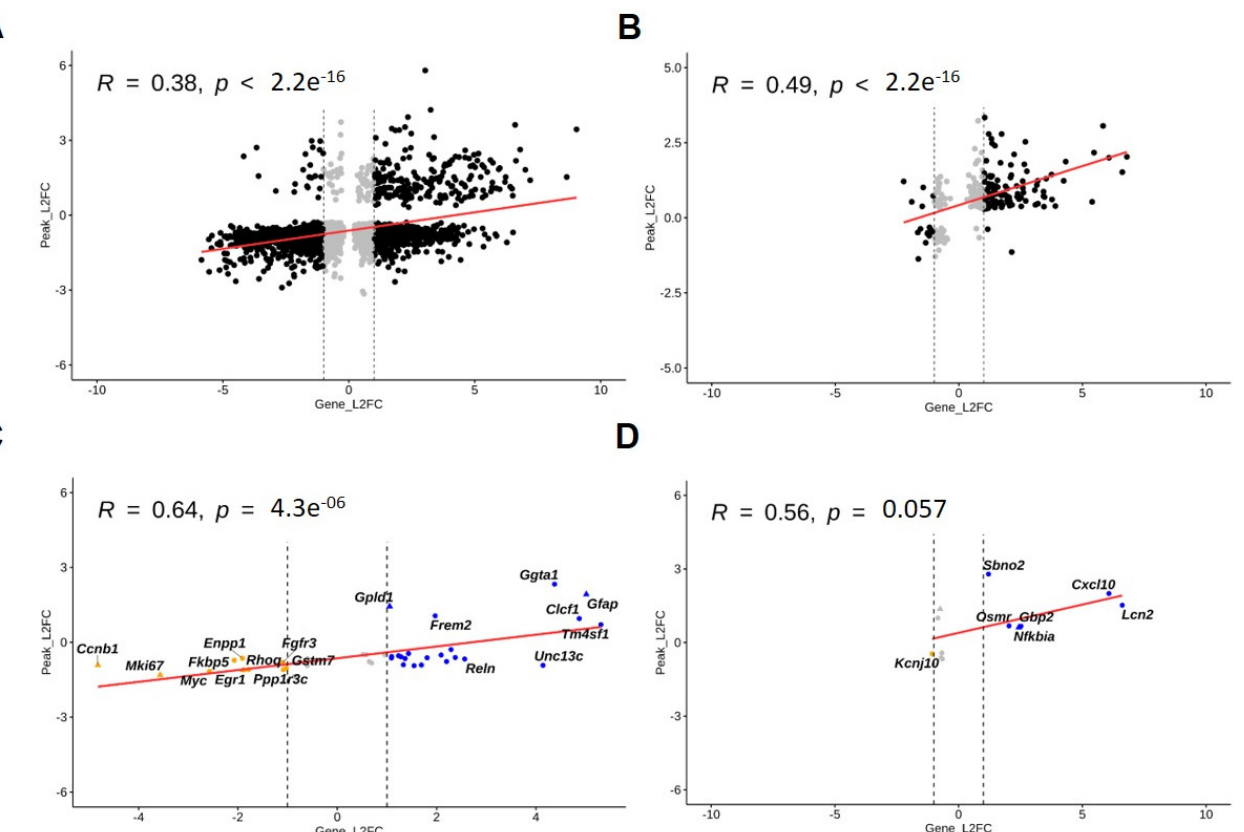
Figure 6. Correlation analyses of transcriptional and chromatin accessibility changes upon the differentiation process under normal and inflammatory conditions. Scatter plots for combined RNA-seq and ATAC-seq data ( A , B ) at the genome-wide level and ( C , D ) at specific NSC, resting and reactive astrocytic gene loci at 24 h under ( A , C ) normal and ( B , D ) inflammatory conditions. Plots display Pearson’s correlation coefficient indicating correlation levels between RNA-seq and ATAC-seq data, along with corresponding p -values (considering differentially expressed genes with adjusted p value < 0.05 and differentially accessible peaks with false discovery rate (FDR) <0.05). Blue and orange dots represent marker genes, which are significantly differentially expressed (adjusted p value < 0.05), have more than 2-fold positive change (upregulation) or more than 2-fold negative change (downregulation), respectively, in gene expression and have a significantly differentially accessible peak (FDR < 0.05) in their promoter region. Red lines represent the regression line of correlation between fold change in gene expression and